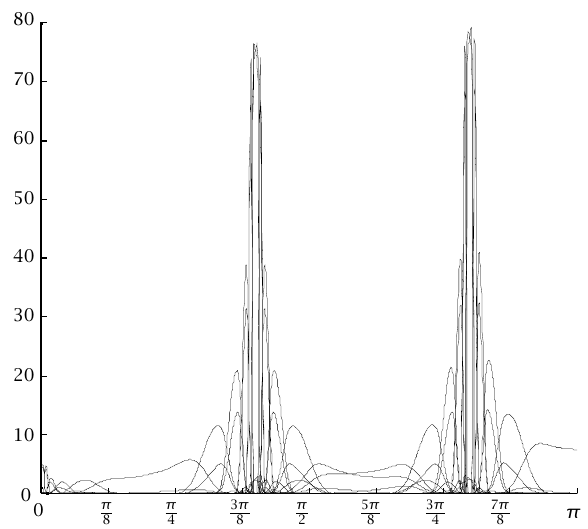
Figure 8: Magnitude Fourier transform of harmonic-band